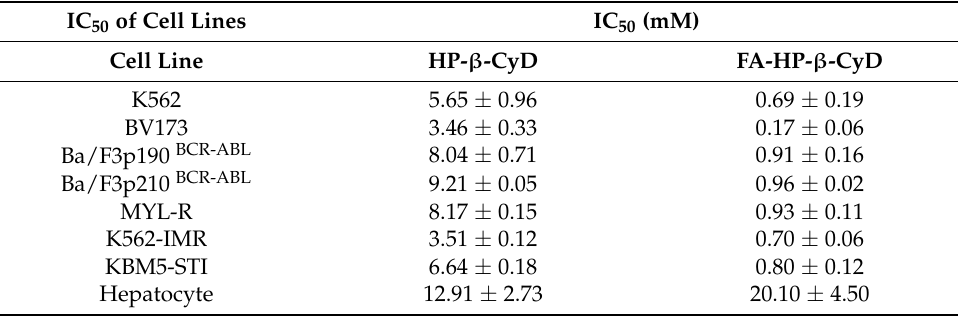
Table 1. IC 50 values of HP- β -CyDs in various CML cell lines.